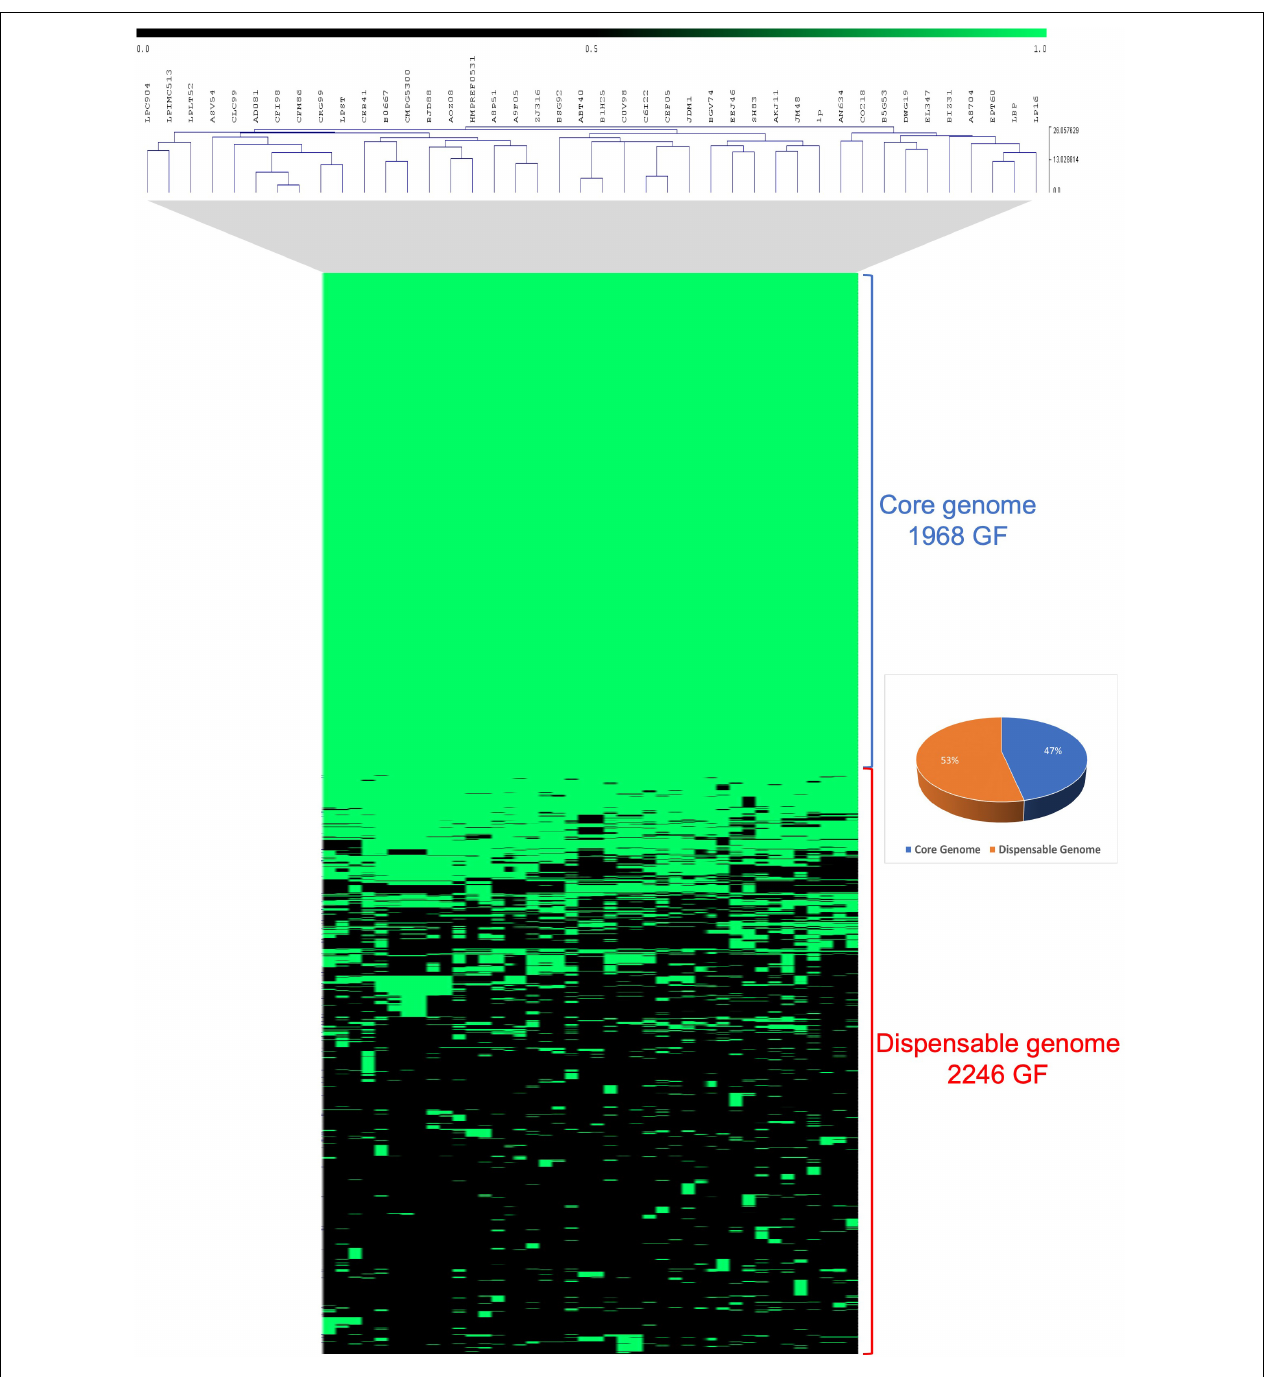
FIGURE 2 | Comparative analysis of 42 Lpb. plantarum strains. Comparative analysis realized in Tmev viewer and representing the presence/absence of gene families (GF) from the core and dispensable genomes of 42 Lpb. plantarum strains. Presence is indicated in green while absence is indicated in